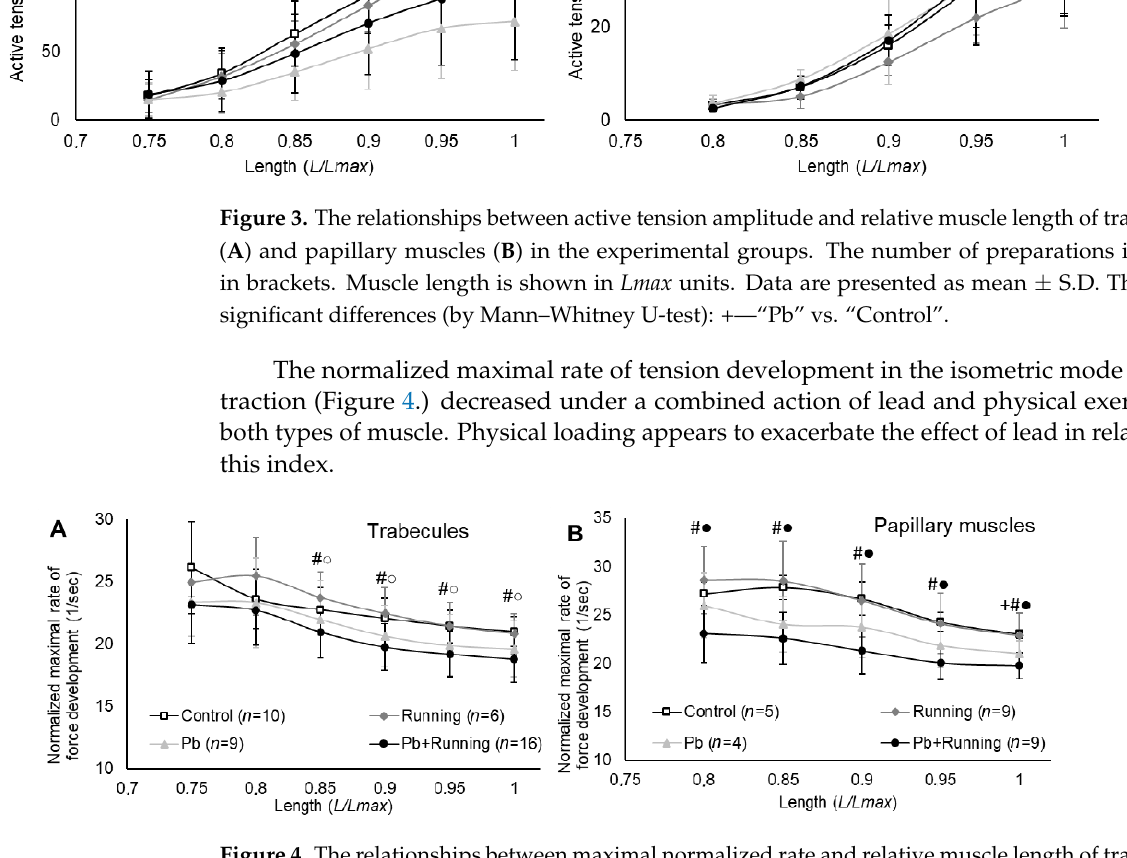
Figure 4. The relationships between maximal normalized rate and relative muscle length of trabecules ( A ) and papillary muscles ( B ) in the experimental groups. The number of preparations is given in brackets. Muscle length is shown in Lmax units. Data are presented as mean ± S.D. There are significant differences (by Mann–Whitney U-test): #—Pb + “Running“ vs. “Control”; • —“Pb + Running” vs. “Running”; —“Pb” vs. (cid:35)